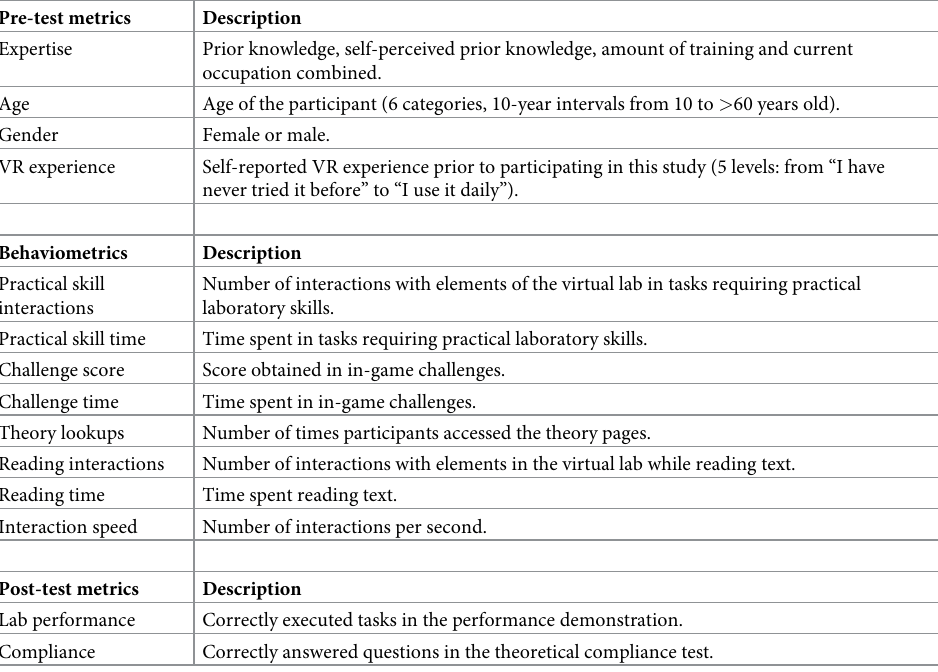
Table 1. Behavioral patterns from the VR simulation and self-reported personal information to predict compli- ance, physical lab performance and expertise. Pre-test